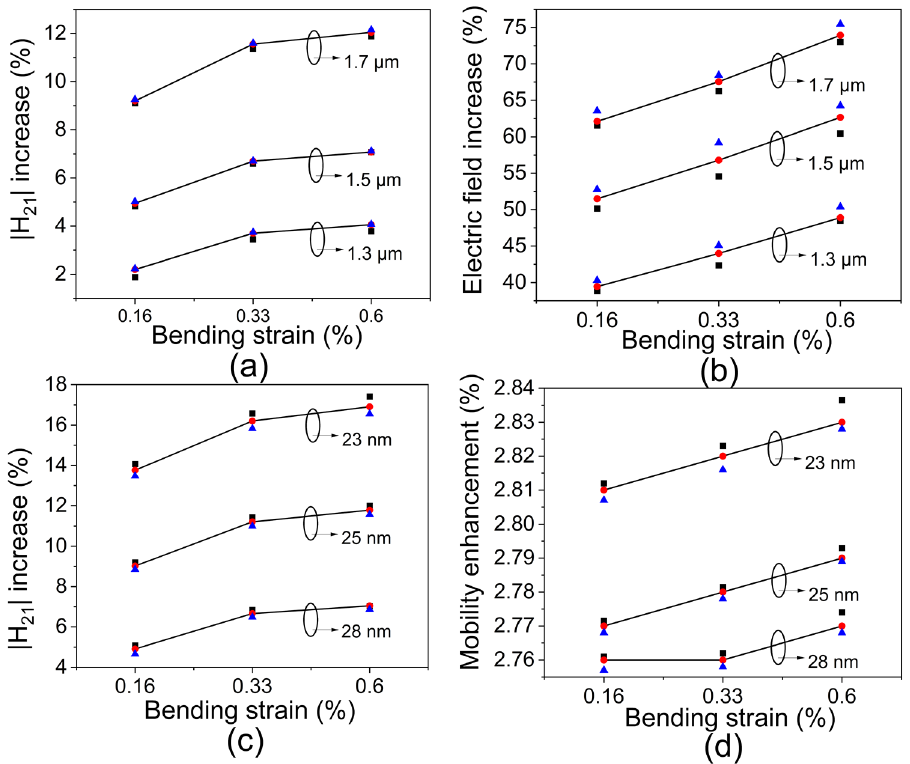
Figure 4. Change of the simulated ( a ) H 21 (in percentage) and ( b ) electric field of the TFTs (gate length = 1.3, 1.5, and 1,7 μ m) with different bending strains. Change of the simulated ( c ) H 21 (in percentage) and ( d ) carrier mobility of the TFTs (gate dielectric thickness = 23, 25, and 28 nm) with different bending strains. (Red circle: gate length for ( a , b ), gate dielectric thickness for ( c , d ). Black rectangle: gate length changed by − 1% for ( a , b ), gate dielectric thickness changed by − 1% for ( c , d ). Blue triangle: gate length changed by +1% for ( a , b ), gate dielectric thickness changed by +1% for ( c , d ).)